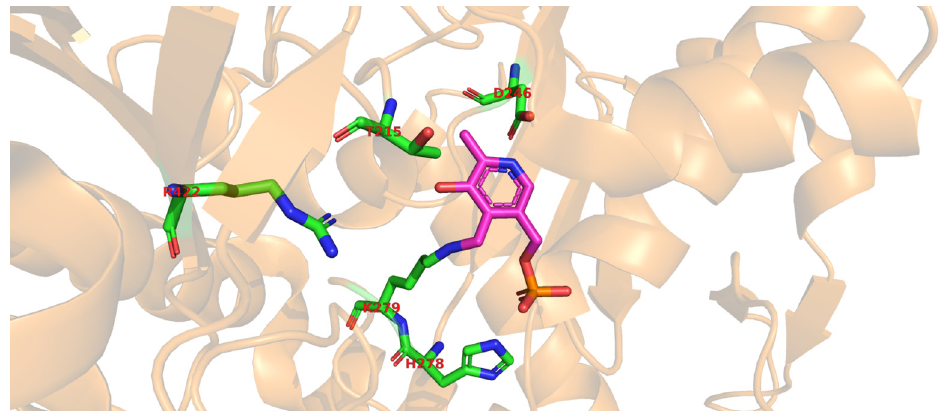
Figure 5. Active site of glutamate decarboxylase from L. brevis (PDB code 5GP4). The conserved catalytic residues T215 and D246 are shown in sticks, colored by atom type, with carbons shown in green, nitrogen in blue, and oxygen in red. The prosthetic group PLP is represented as sticks colored by atom type with carbons in magenta. The residues R422, H278, and K279, proposed to be involved in electrostatic interactions with the substrate glutamate [68], are represented as sticks colored by atom type. The rest of the chain is shown as a transparent orange cartoon. K279 is also involved in forming the imine linkage to PLP. The image was made using the PyMOL Molecular Graphics System, v. 2.3.0. for Linux.